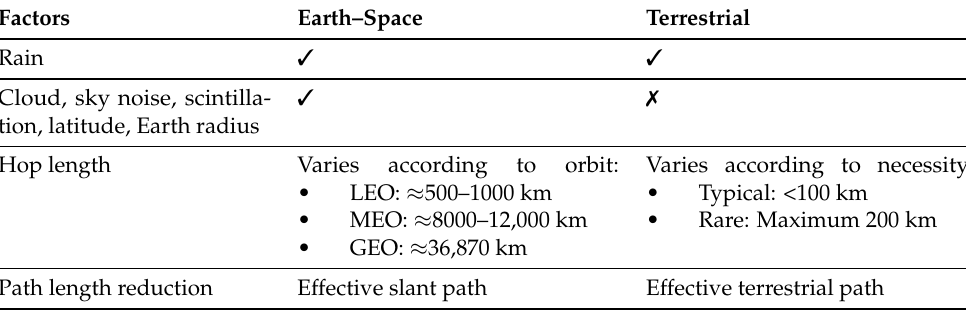
Path length reduction Effective slant path Effective terrestrial